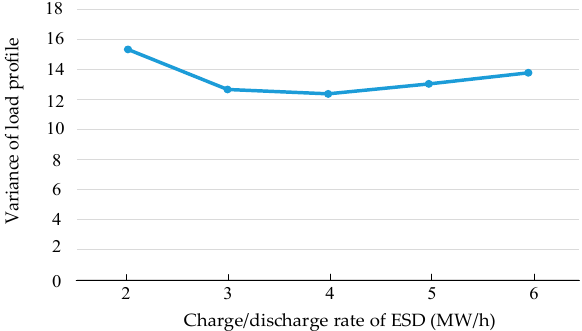
Figure 9. The correlation between payback period and charge/discharge rate of the ESD.